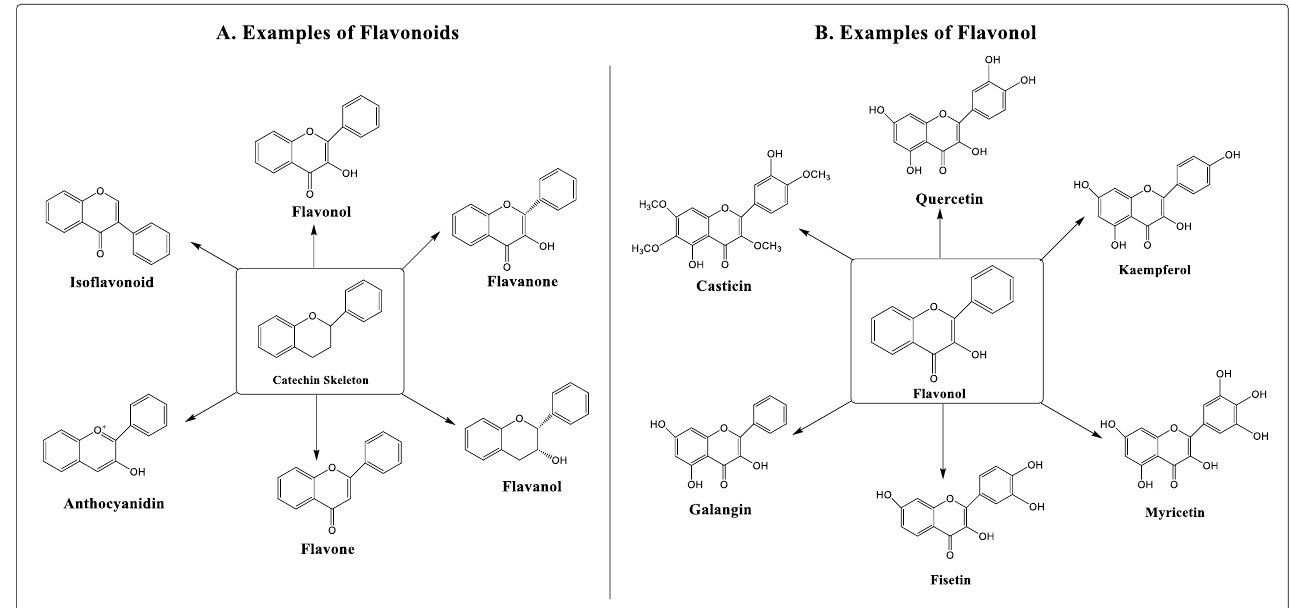
Figure 1. Types and examples of flavonoids ( A ) and flavonols ( B ).